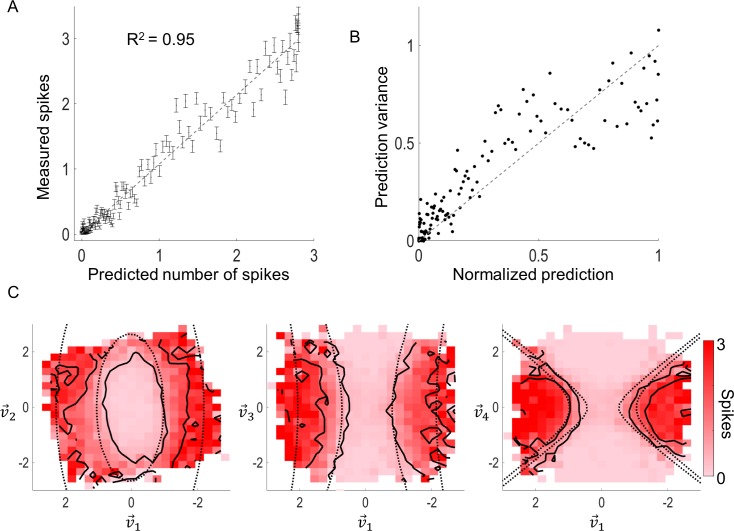
Model validation for a sample cell.A) The predicted response was compared to the average responses (black dots with SEM bars). Each point represents the mean response to 200 stimuli. B) The variance of each point in (A) was compared to the prediction. Both values were normalized to the maximum prediction (~3 spikes). For a Poisson-like process, the values should be equal (indicated by the dashed line). C) The contours of fixed response expectation (dotted black) were computed using the predicted model parameters (Eq (6)). These contours were compared to the contours generated from the experimental data (solid black) when projected onto the principal excitatory component and the second excitatory component (left), third excitatory component (middle), or a suppressive component (right). The contours denote the expectations of 1 and 2 spikes.